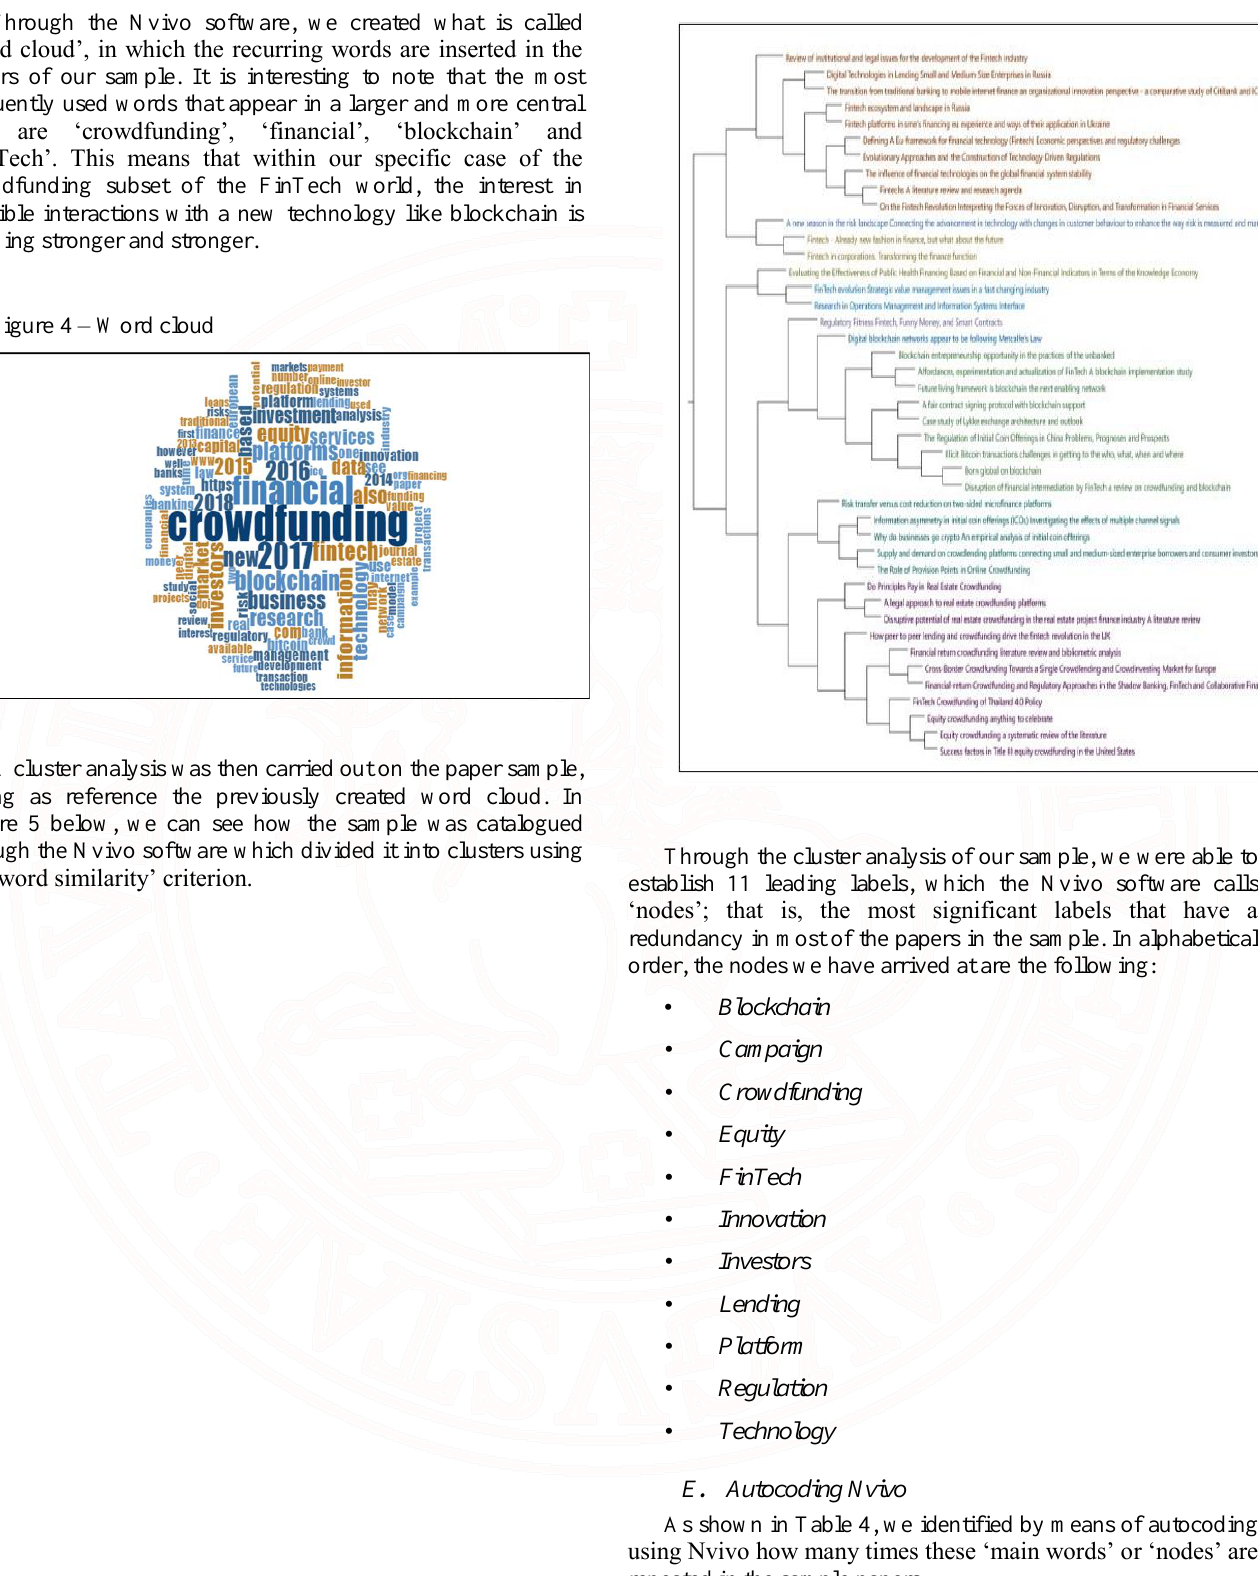
Figure 5 – Sample data clustered by word